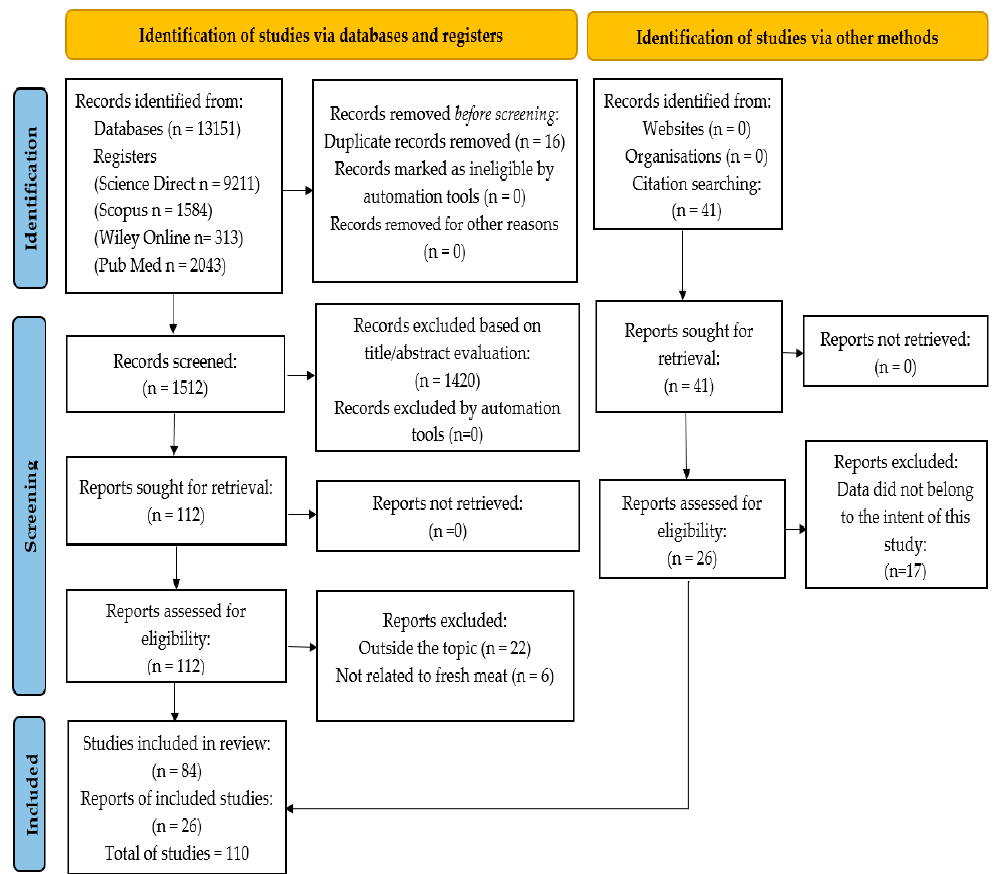
Figure 2. PRISMA flow chart for article selection between the years 2000 and 2022 in the influence of Figure 2. PRISMA fl ow chart for article selection between the years 2000 and 2022 in the in fl uence intrinsic and extrinsic factors in beef meat color of intrinsic and extrinsic factors in beef meat color [21].